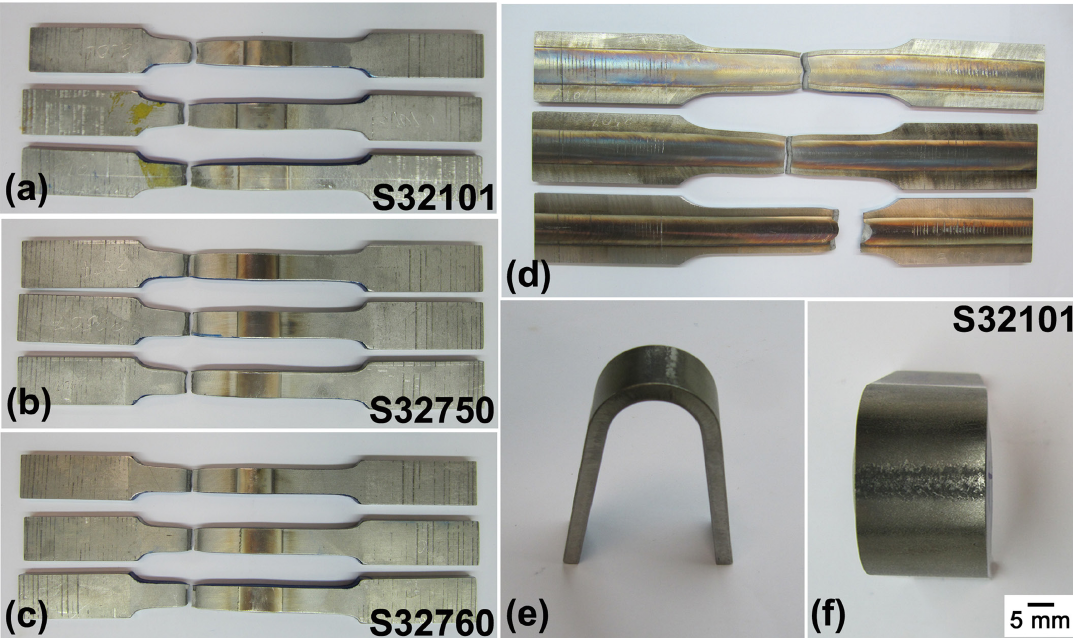
Fig. 14. Transverse tensile tests of UNS (a) S32101, (b) S32750, and (c) S32760. Longitudinal tensile tests (d) of UNS S32101, S32750, and S32760 FSW joints. (e)-(f) Different views of bent samples of